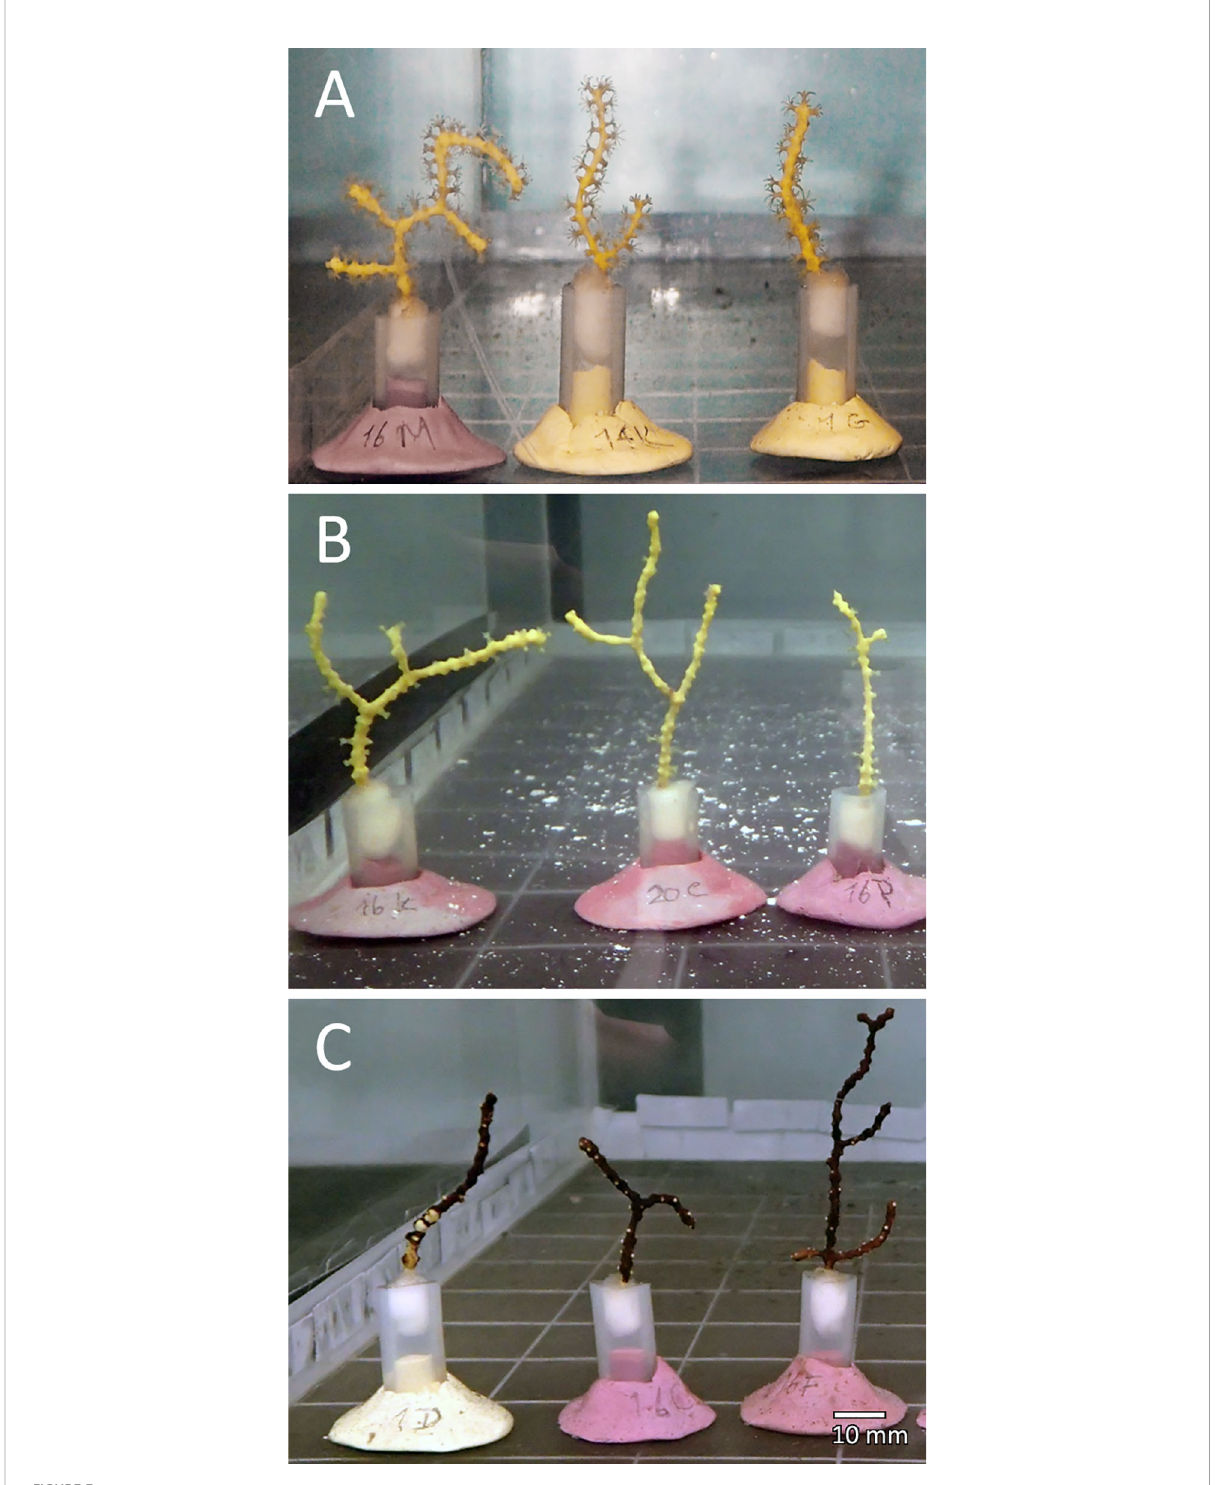
FIGURE 3 Dentomuricea aff. meteor fragments exposed to the different treatments (A) Control; (B) Quartz particles; and (C) Polymetallic sulphide particles, after 3 days of treatment